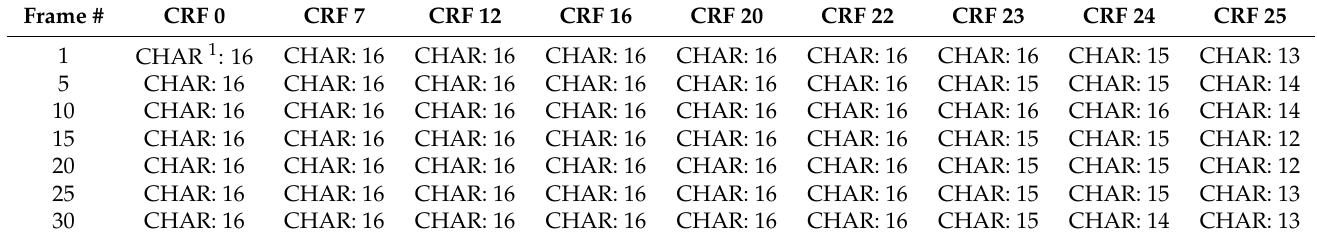
Table 10. Algorithm performance results for a 480 × 640 video fragment encoded with a 128 × 128 encoder trained for CRF = 24 for changes in CRF coefficient in the form of a number of correctly decoded characters.